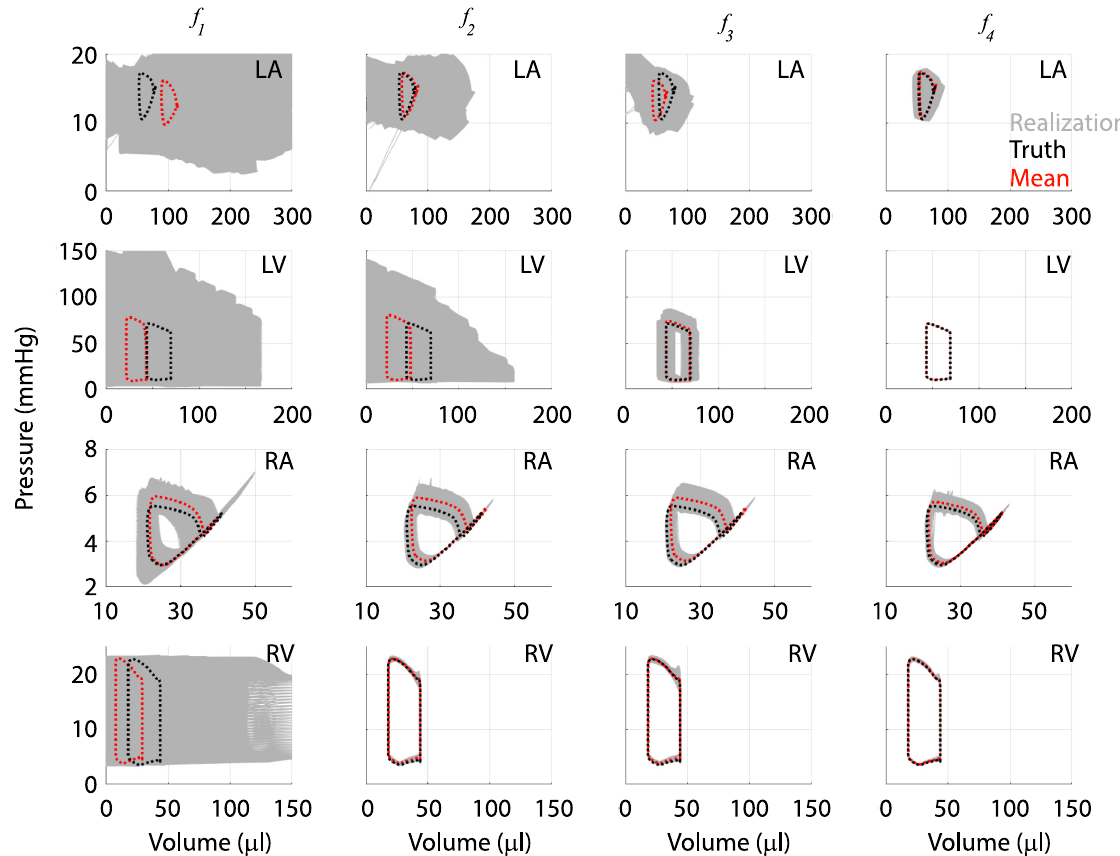
Fig 10. Output uncertainty in cardiac pressure-volume loops. Realizations in forecasts of chamber pressure-volume loops in the LA (first row), LV (second row), RA (third row), and RV (fourth row). The simplest design ( f 1 ) has the largest uncertainty in simulated pressure- volume loops, except for RV pressure, which is accounted for in the likelihood. Subsequent experimental designs substantially reduce uncertainty bounds in the RV and RA ( f 2 ) and eventually in the LV and LA ( f 3 and f 4 ).